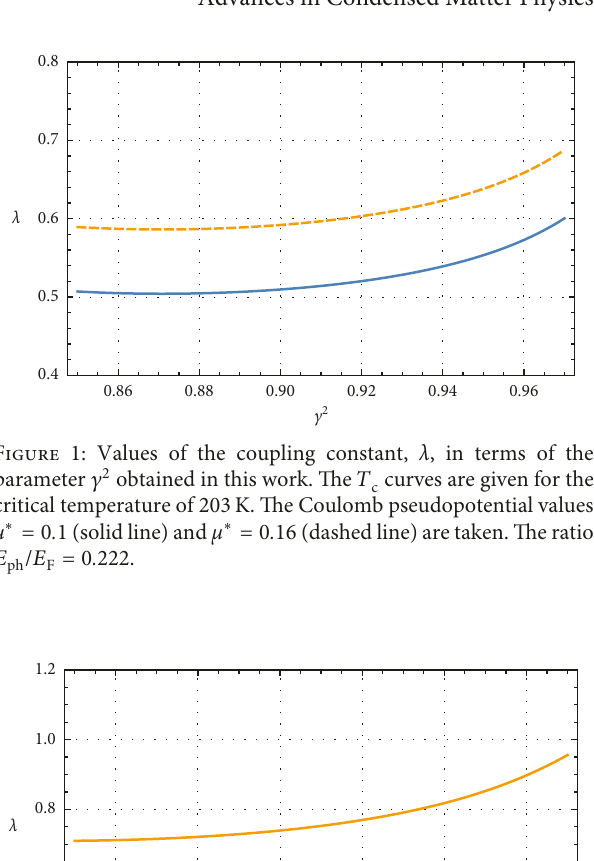
� 203K. The Coulomb c � 200meV for the ph � 0 . 285 / E ph F